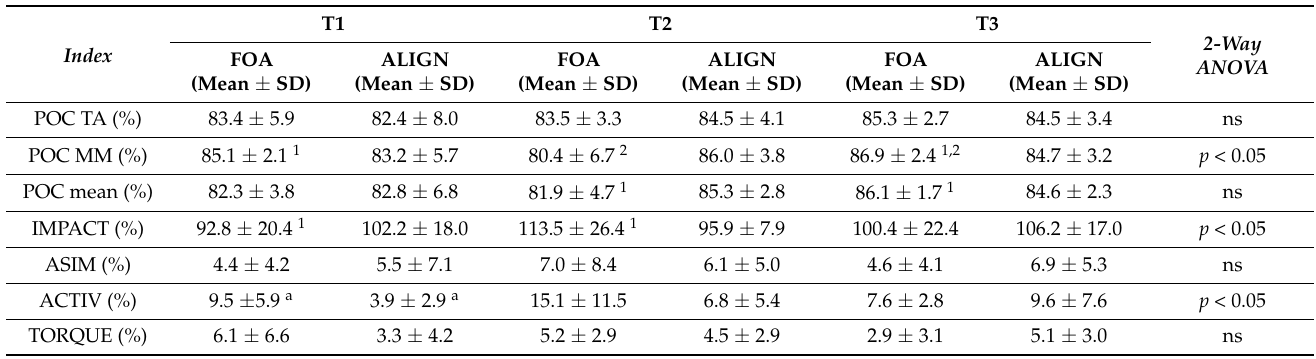
Table 2. Mean and standard deviation (SD) relating to all standardized electromyographic indexes within the FOA and ALIGN groups at T1, T2, and T3 are shown: POC (%), IMPACT (%), ASIM (%), ACTIV (%), TORQUE (%) (masseter muscles MM, temporalis muscles TA). Two-way ANOVA with repeated measures on one factor was performed between groups and significance was set at 5% ( p <